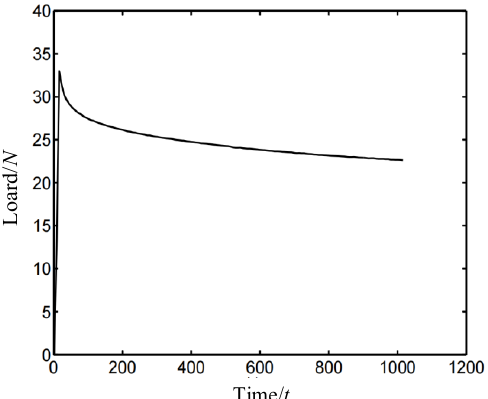
Figure 1. Stress–relaxation curve of silicone